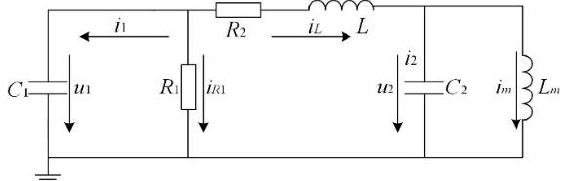
Figure 4. Equivalent circuit during breakover of the IGBT. u 1 and u 2 are the potential differences of the capacitor. i 1 , i 2 , i L , i R1 are the current flows in this circuit.